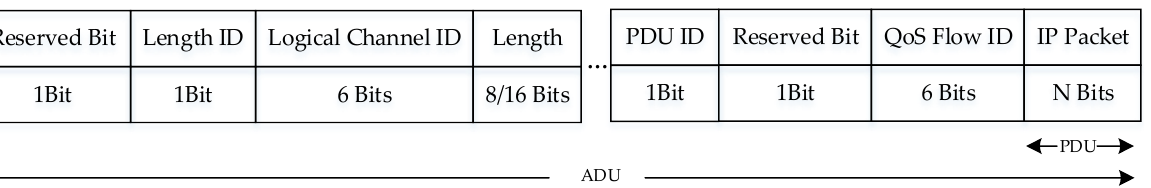
Figure 3. The uplink frame structure of the user plane in the data link layer.